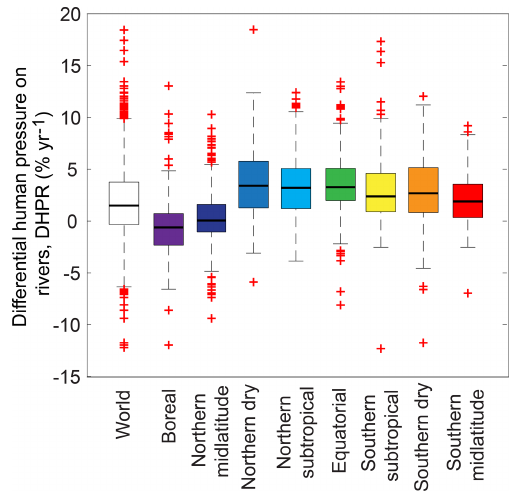
Figure 4. Regional patterns of the Differential Human Pressure on Rivers index, DHPR. Box plot statistics for DHPR grouped by hydrobelt (Meybeck et al., 2013): world (2195 basins), bo- real (170 basins), northern midlatitude (800 basins), northern dry (133 basins), northern subtropical (319 basins), equatorial (354 basins), southern subtropical (141 basins), southern dry (84 basins), southern midlatitude (194 basins). Box plots include the median (thick black line), interquartile range (colored boxes) and whiskers (confidence interval of ± 2 . 7 σ